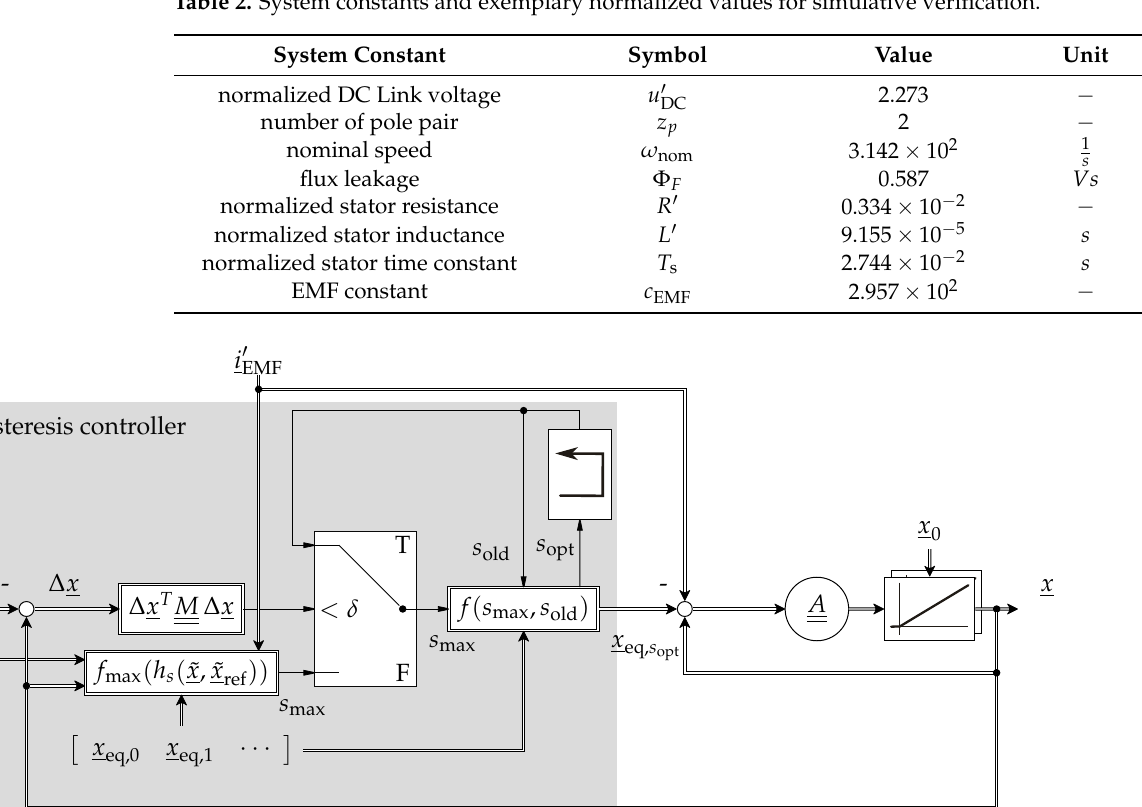
Table 2. System constants and exemplary normalized values for simulative verification.